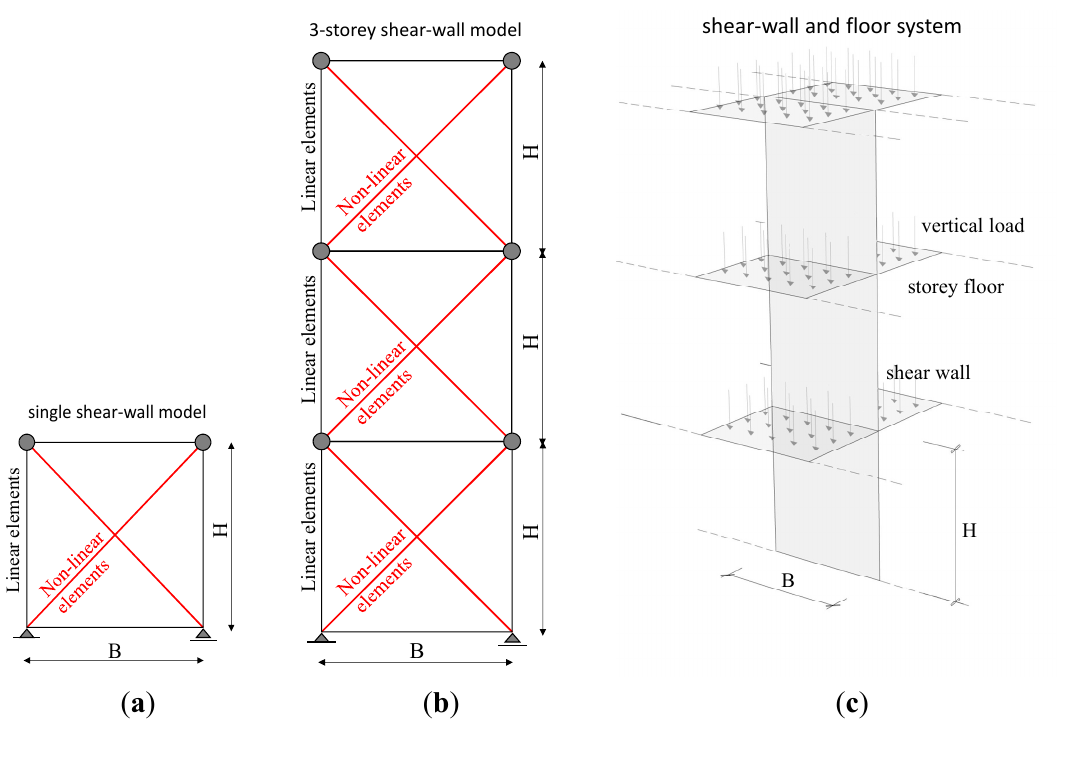
Figure 16. Scheme of specimens used for: ( a ) calibration; ( b ) simulations; ( c ) design.